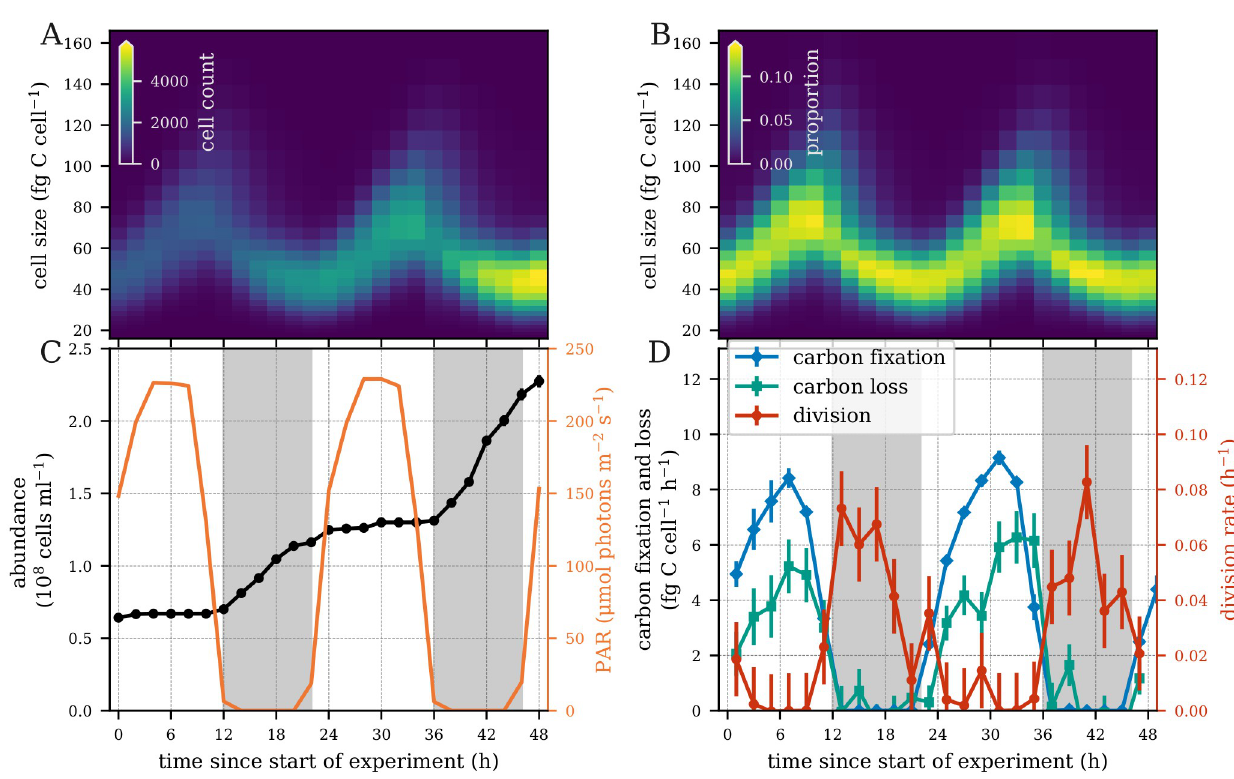
Fig 2. Laboratory Prochlorococcus time series measurements. (A) Heatmap of the number of cells and (B) relative cell abundances in each size class measured every two hours over a 48-hour period. (C) Cell abundance and photosynthetically active radiation (PAR). (D) Hourly carbon fixation, carbon loss, and division rates. Error bars indicate one standard deviation based on two technical and two biological replicates.